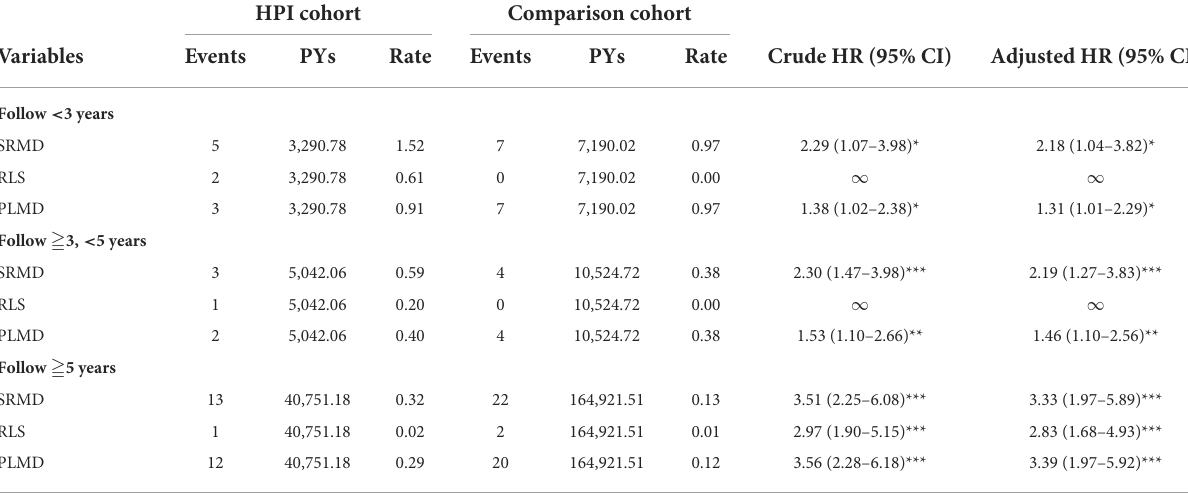
TABLE 3 Factors of SRMD subgroup stratified by follow-up time for Cox regression analysis. HPI cohort Comparison